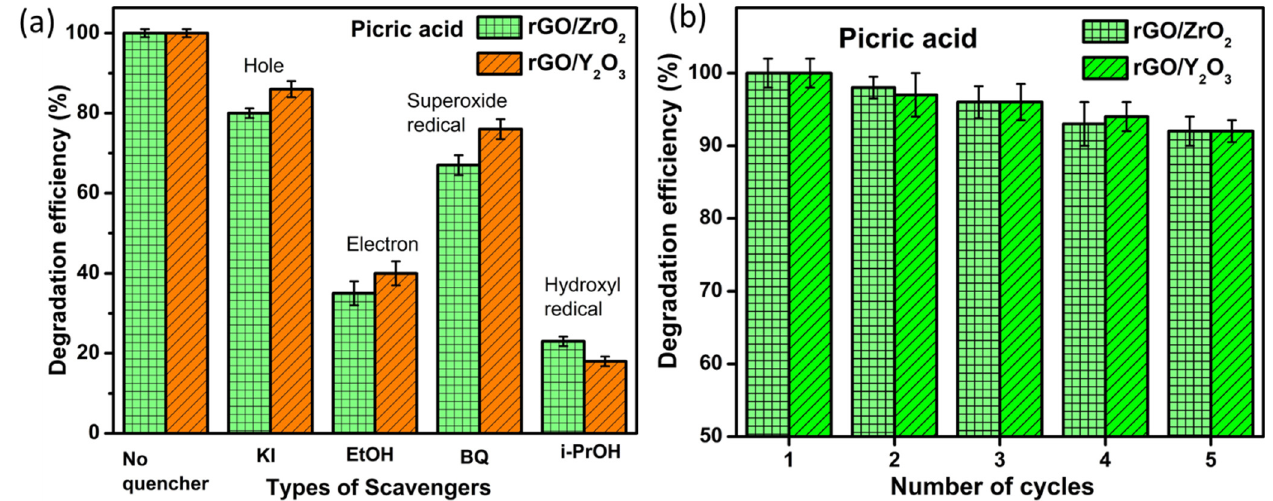
Figure 7. ( a ) Scavenger test ( b ) reusability study of rGO-ZrO 2 and rGO-Y 2 O 3 nanocomposites for Picric acid degradation. Table 1. Comparison studies of recently reported literature on photocatalytic parameters.